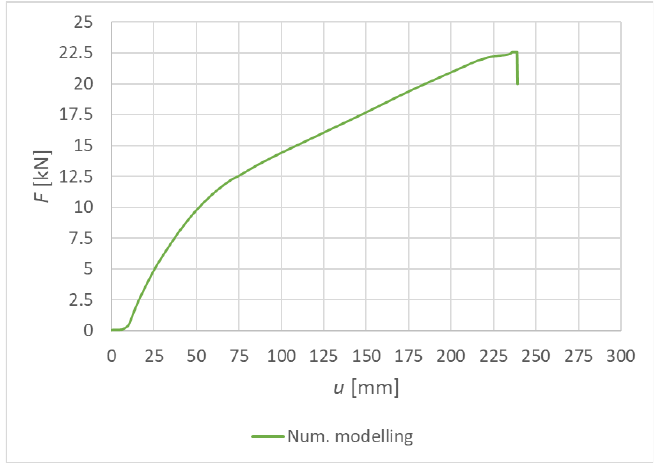
Table 8. Results of numerical modeling, Experiment A.